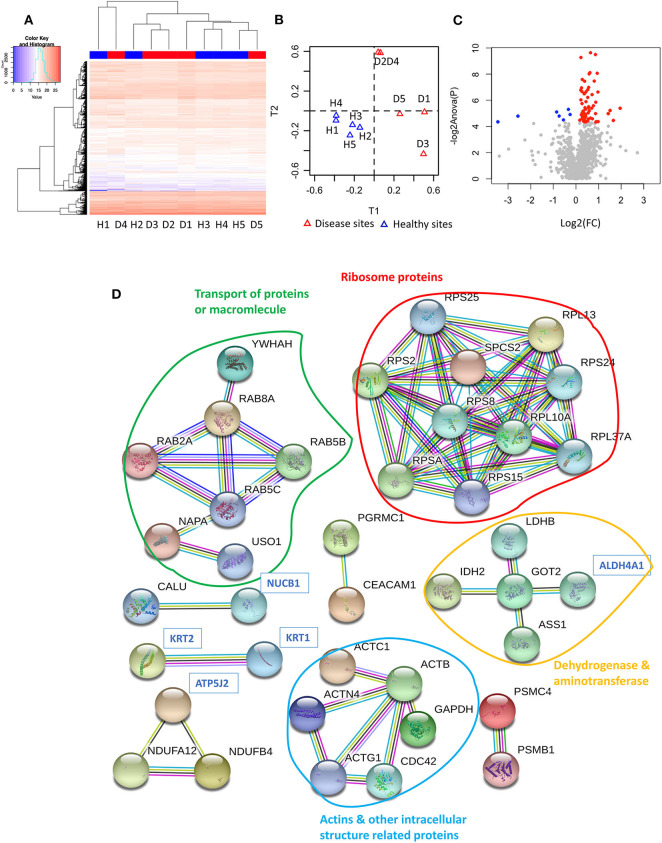
Proteome of gingival tissues from healthy and diseased sites. (A) The heatmap of normalised abundance for identified and quantified proteins in gingival tissue. Samples isolated from healthy sites were highlighted in blue colour, while samples isolated from diseased sites were highlighted in red. (B) The sPLS-DA plots represented the normalised abundance of all the 1,366 proteins from healthy (blue triangles) or diseased sites (red triangles). (C) 62 proteins were upregulated [log2 (FC) ≥ 0, P ≤ 0.05] in the disease compared with healthy sites (red dots), and 7 were downregulated [log2 (FC) ≤ 0, P ≤ 0.05]. (D) String analysis for the interaction between regulated proteins. Network established using STRING with interaction confident scores more than 0.9. The upregulated proteins were labelled in black, while the downregulated proteins were labelled in blue. The methods for acquiring the different protein-protein interactions were illustrated by different lines. The interaction confirmed by the curated database and experimental results were shown in blue and purple line, respectively. The interaction predicated by gene neighborhood, gene fusions, and gene co-occurrence were shown in green, red, and dark blue lines, respectively. While interaction was determined by text-mining, co-expression and protein homology were shown in yellow, black, and light blue lines, respectively. Healthy sites: H. Diseased sites: D.